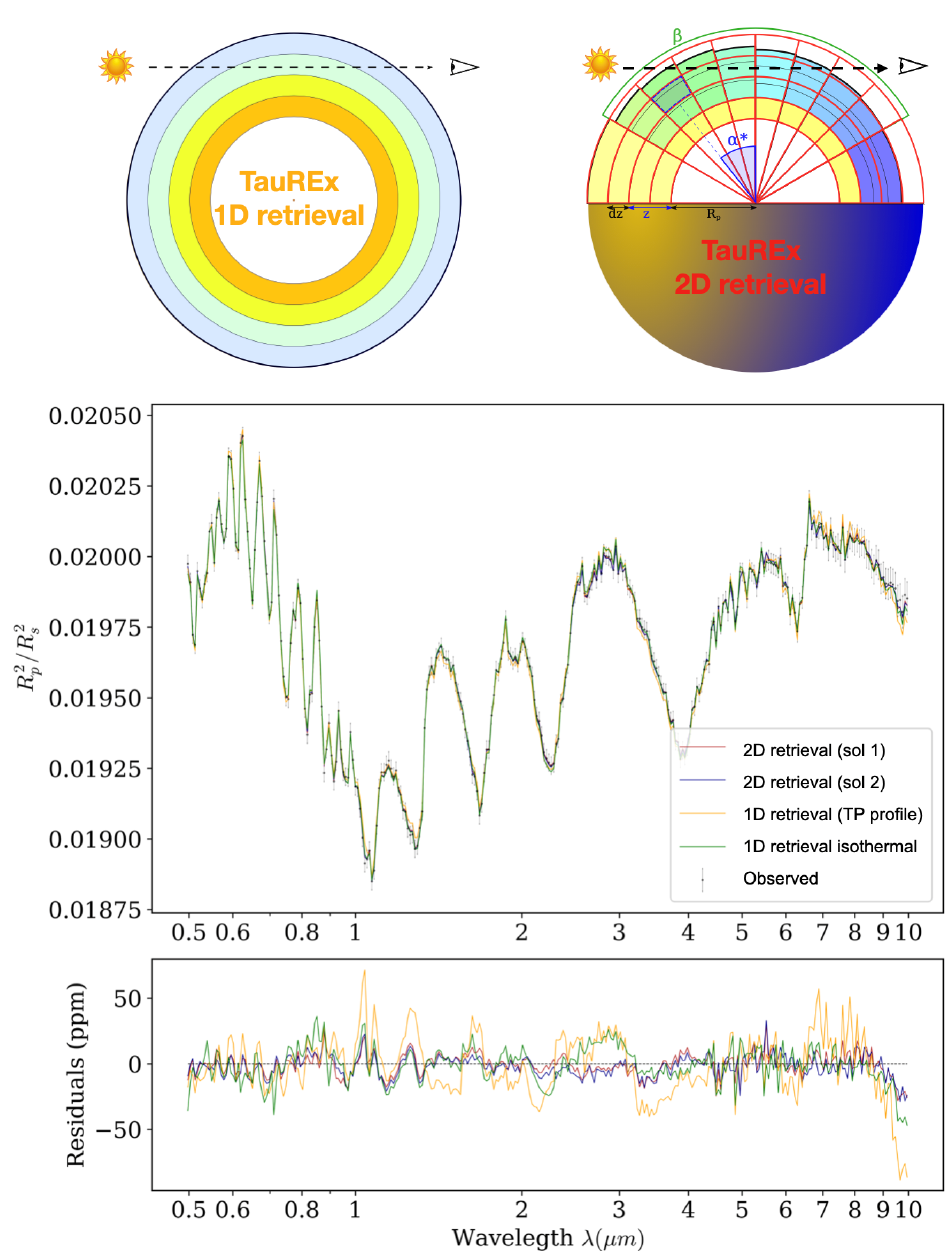
Figure 11. ( Top ) Visual representation of the 1D model (left) only relies on altitude and 2D model (right) using a polar grid whose the radial axis is the altitude and whose angular axis follows the solar altitude angle ( α ∗ ). ( Middle ) Retrieved transmission spectra of simulated WASP-121b (black dots) from the 1D model using isothermal TP profile (green) and 4-point TP profile (yellow). The two solutions from the 2D model are shown in blue and red. ( Bottom ) Residuals between the observed spectrum and the retrieved spectrum in ppm. Figure adapted from